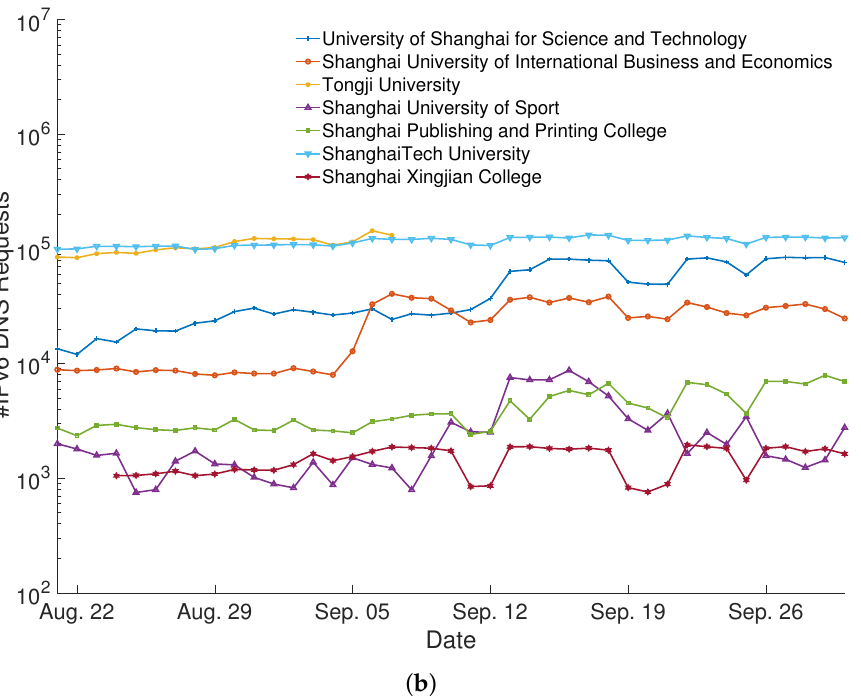
Figure 3. ( a ) DNS request number using IPv4 at seven universities. ( b ) DNS request number using IPv6 at seven